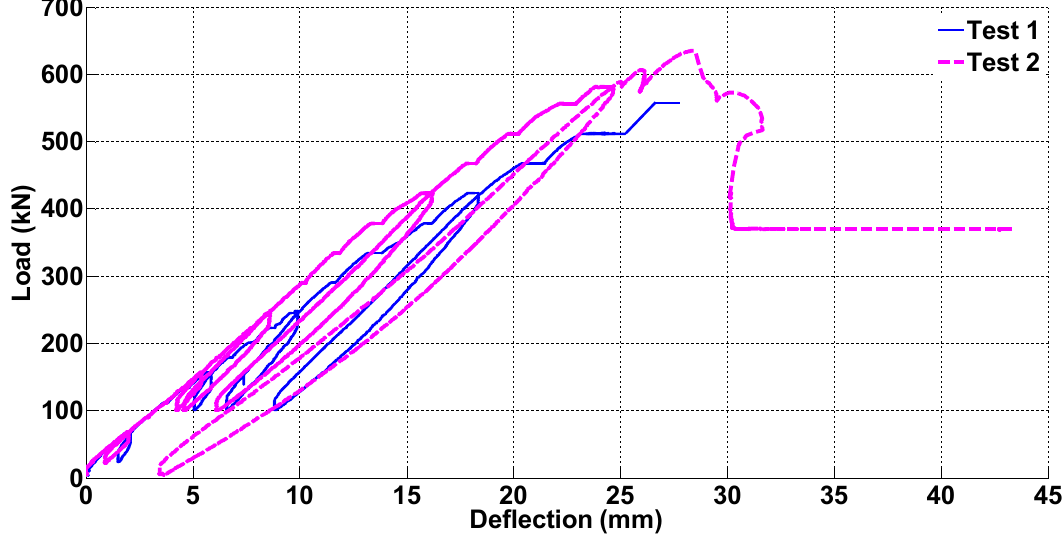
Figure 6. Load–deflection diagrams for the shear tests. The deflection was measured under the loading point.